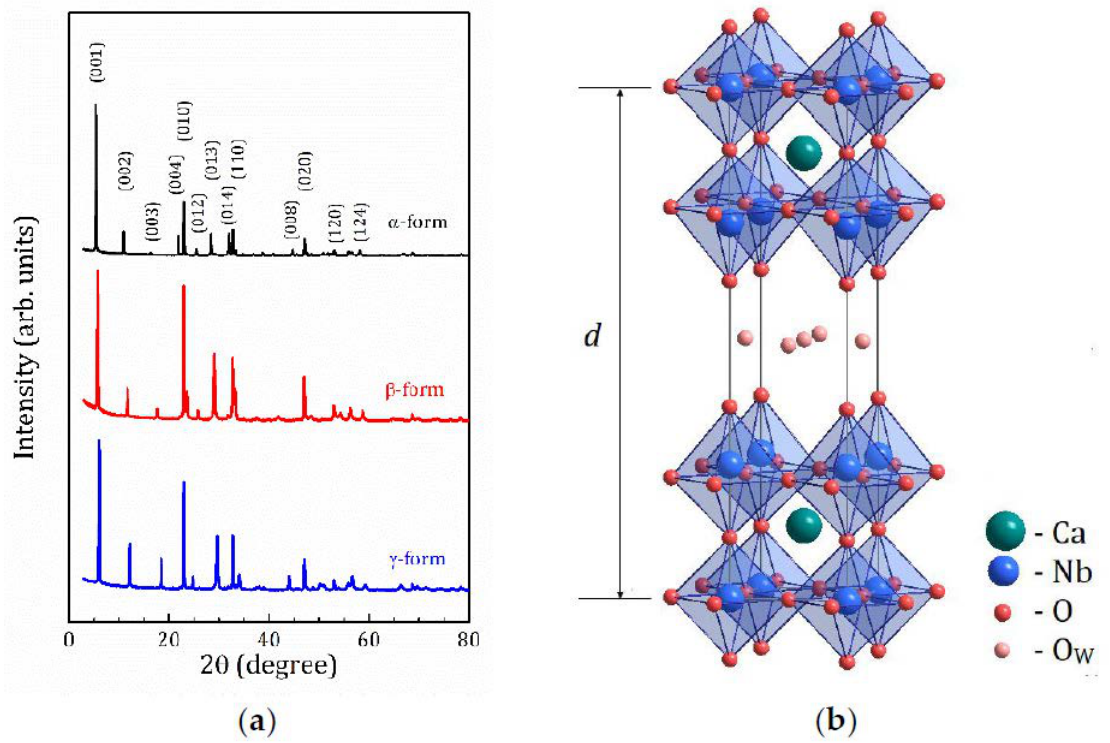
Figure 1. XRD powder patterns for the studied forms of HCa 2 Nb 3 O 10 · y H 2 O with different hydration levels ( a ) and the unit cell of HCa 2 Nb 3 O 10 · y H 2 O ( b ) with possible sites for the water oxygen O w